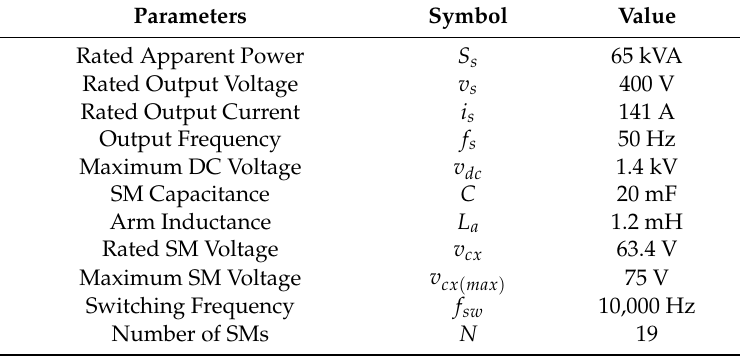
Table A1. Parameters of MMC